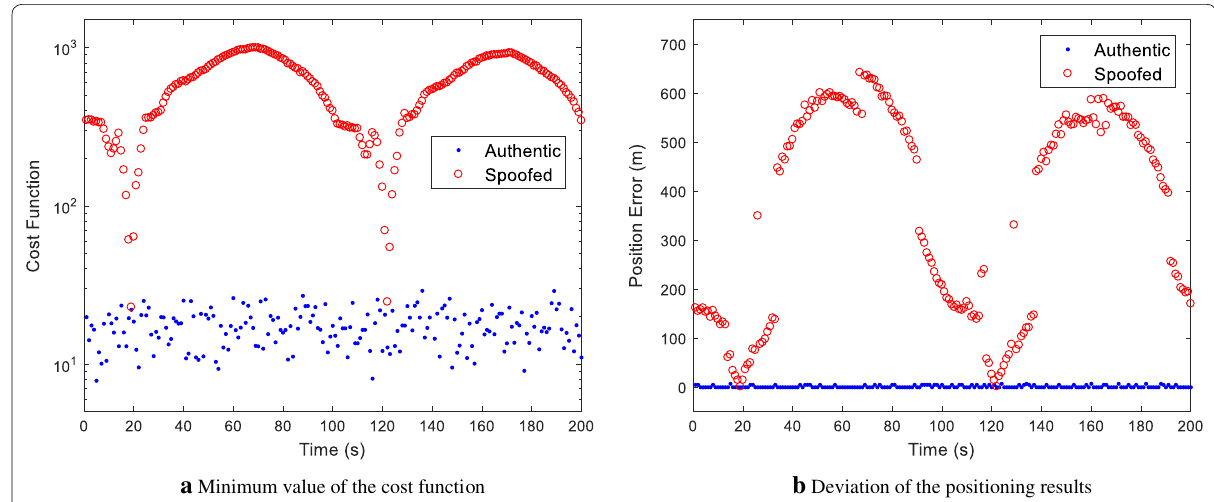
Fig. 7 Simulation results of CRDSS method under spoofing attack. Blue and red dots indicate results when using authentic and falsified measurements respectively in third step of the